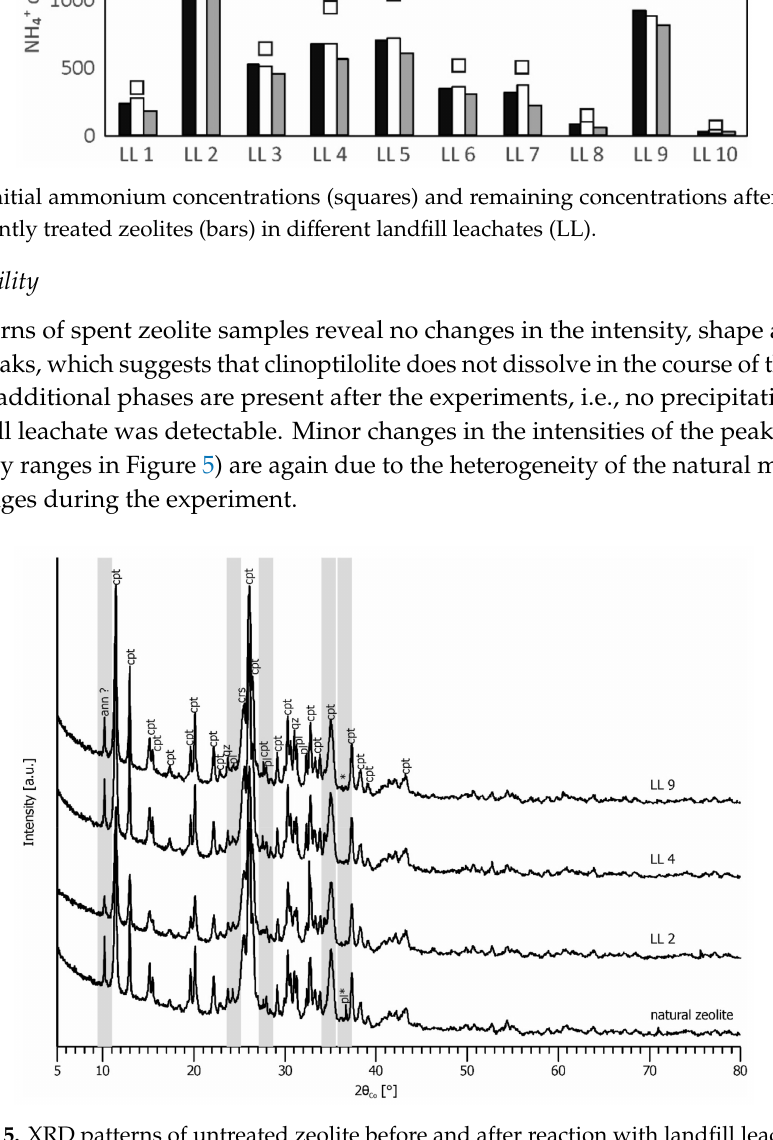
Figure 5. XRD patterns of untreated zeolite before and after reaction with landfill